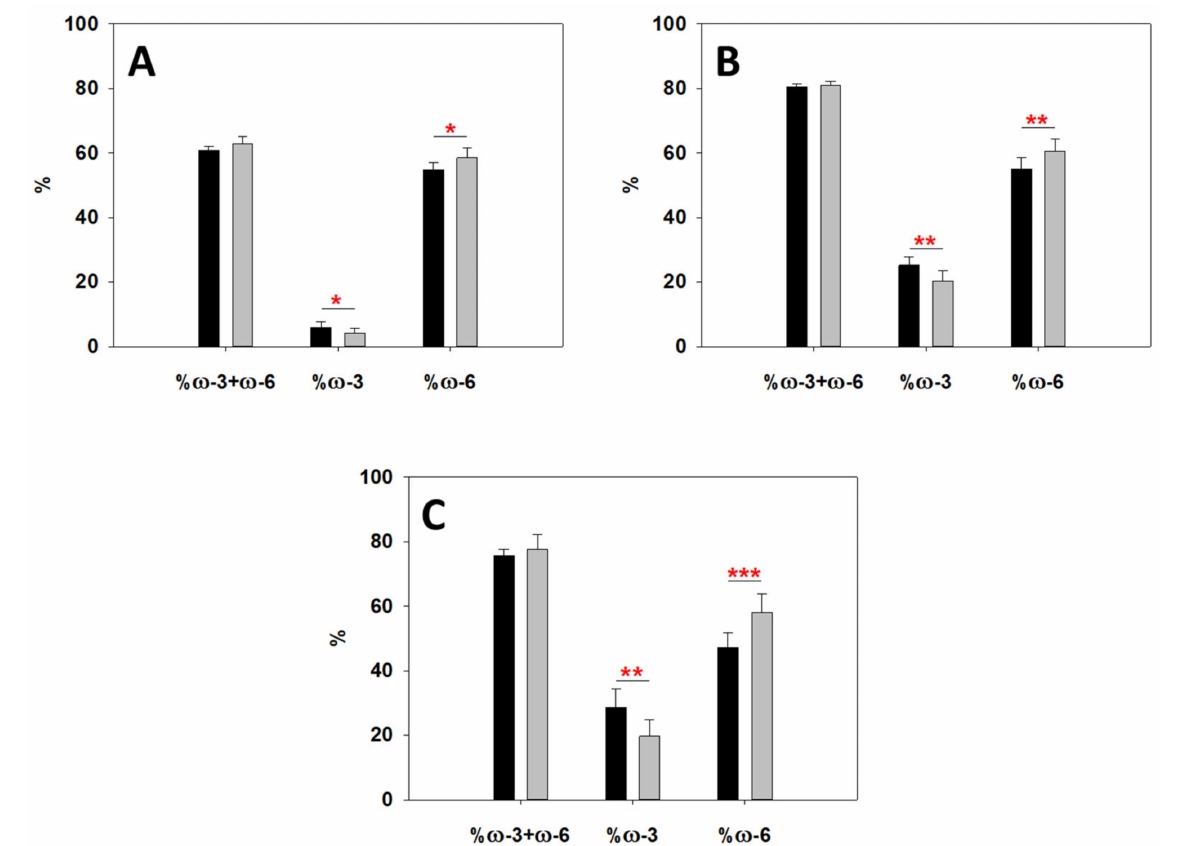
Figure 6. Lipidomic analysis of ω -3 and ω -6 presence in specific lipid species. Percent ω -3 and/or ω -6 in PC ( A ), PE ( B ), and PS ( C ). Black bars refer to control RBC group, while gray bars represent